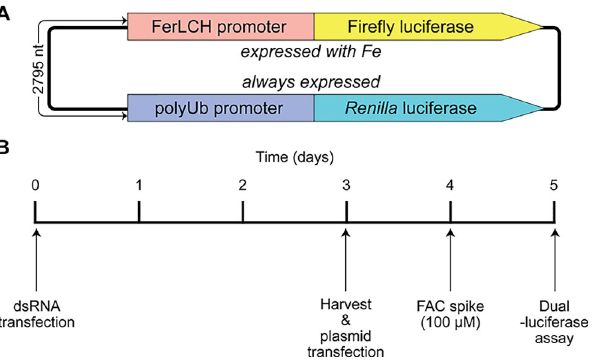
Fig 2. Graphical representation of dual-luciferase reporter plasmid and assay procedure. (A) Two luciferase reporter genes in a single plasmid in tail-to-tail orientation. FerLCH: Ae . aegypti ferritin light chain (AAEL007383). polyUb: Ae . aegypti poly-ubiquitin (AAEL003888). (B) Timeline for gene silencing and dual-luciferase assay procedure. FAC: ferric ammonium citrate.